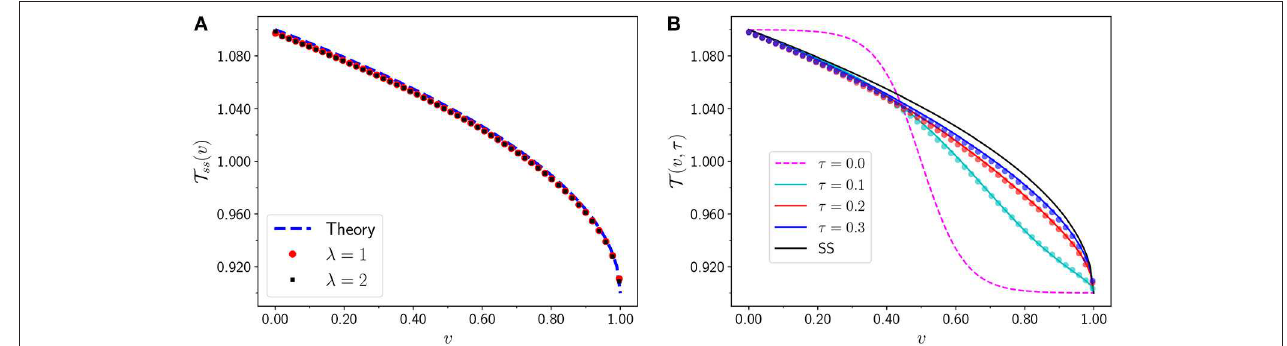
FIGURE 9 | (A) Steady state temperature of HCVE model ( T ss ) as given by Equation (66) (blue dashed line) is compared with numerical simulations for parameters ω γ 1, T ℓ 1.1, T r 0.9, and N 1,024, and for two different choice of λ . (B) Numerical verification of the evolution of the temperature profiles T ( v , τ ) given by = = = = = Equation (71) (solid lines), starting from a non-stationary profile (dashed line). The points indicate simulation results for parameters are λ and N 2,048 (adapted from Kundu et al. with permission from [34] Copyright (2018) by American Physical =